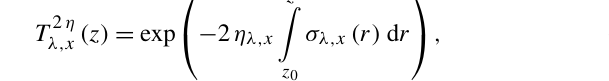
Figure 1. Dependency diagram showing the functional relation- ships between the 532 and 1064nm CALIOP calibration algo-